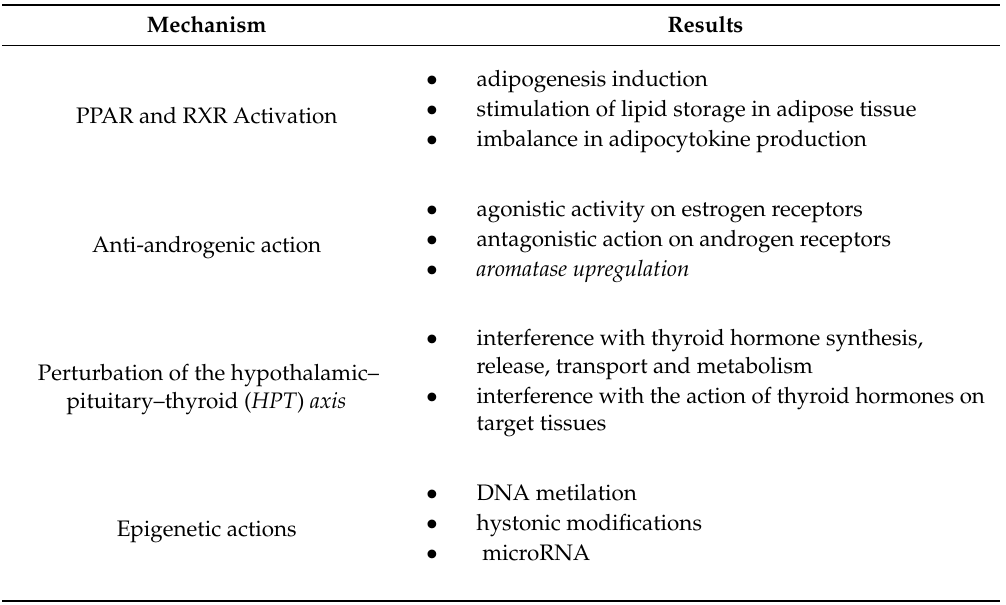
Table 1. Obesogenic hypotesis, adapted by Heindel et al.